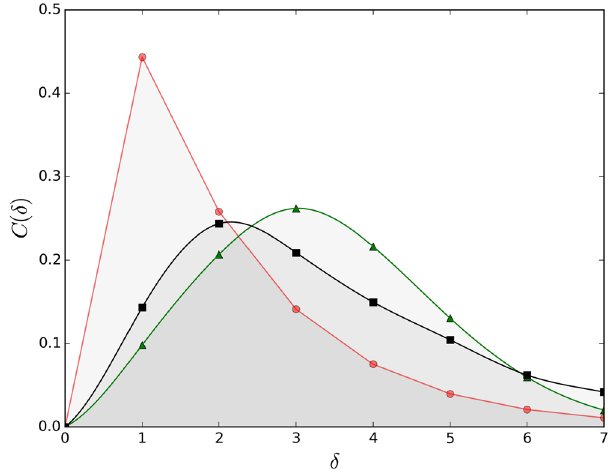
Figure 2. Correlation between the two particles δ = Ψ